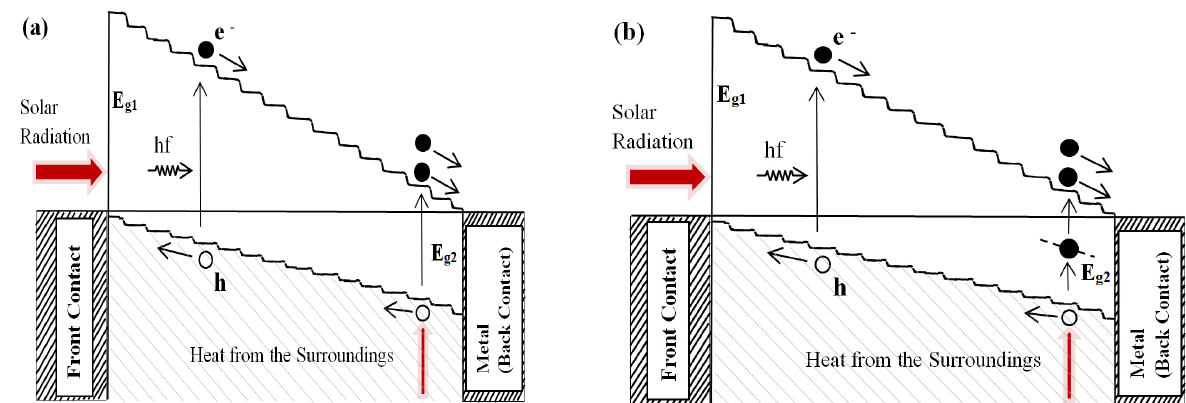
Figure 4. Schematic representation of two types of impact ionisation ( a ) Band-to-band impact ionisation due to energetic electrons and the low bandgap materials towards the back of the device and ( b ) impact ionisation due to combination of photo-generated electrons and impurity PV effect utilising IR radiation from the solar spectrum and the